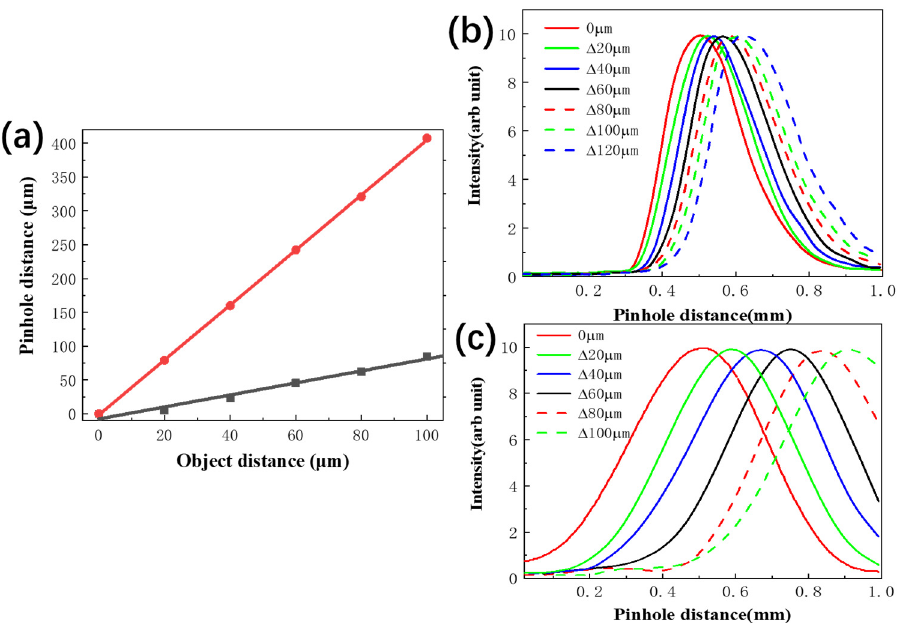
Figure 3. ( a ) Relation of the object distance and a pinhole distance, ( b ) data from Case 1, and ( c ) data from Case 2.